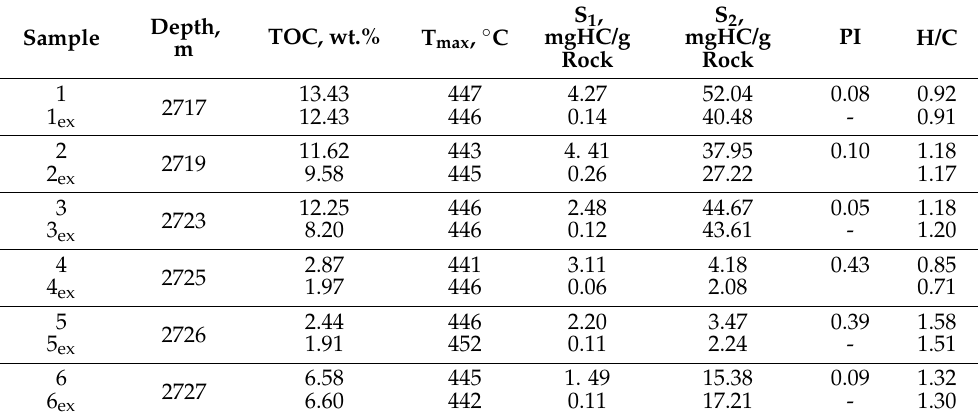
Table 2. General characteristics of shale rock samples before and after bitumen extraction. Abbrevia- tions 1 ex –6 ex are assigned to extracted rock samples 1–6,